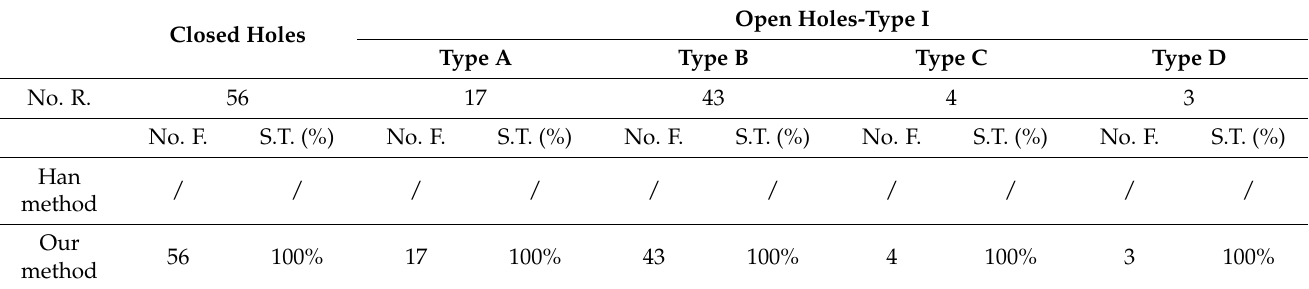
Table 4. Distribution and repair statistics of closed holes and type I open